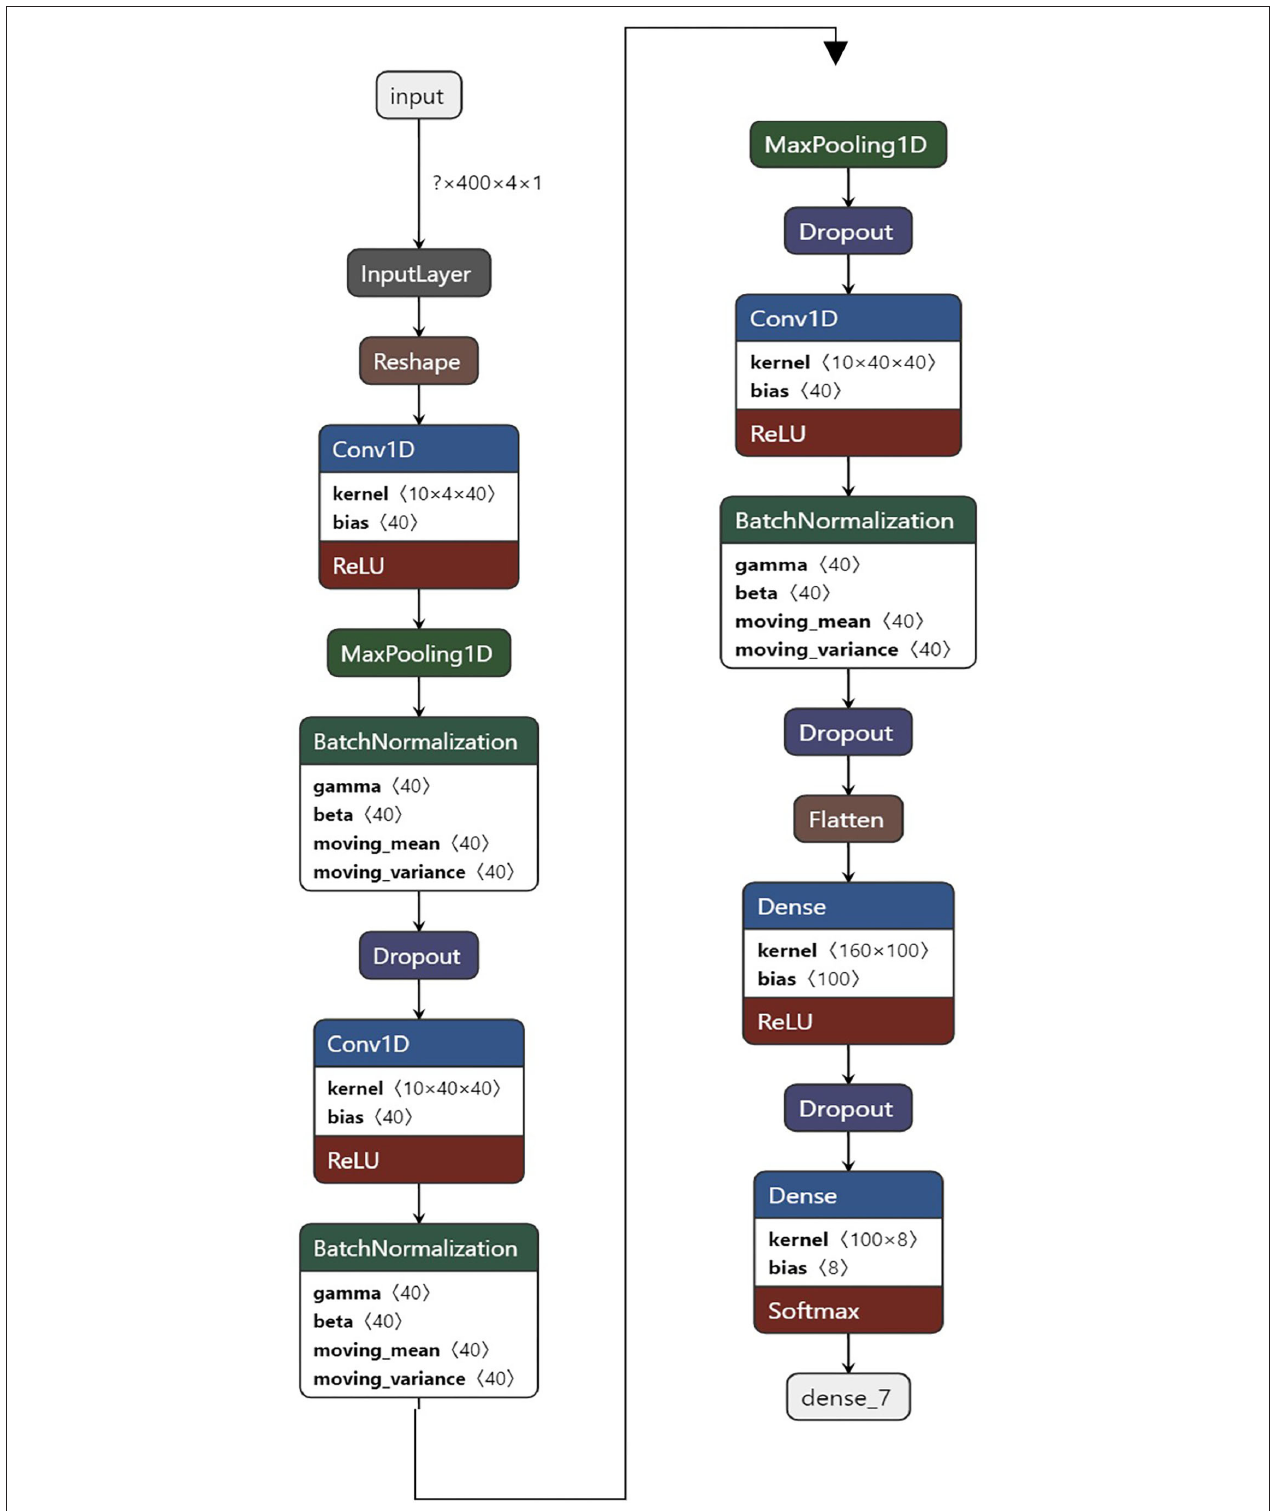
FIGURE 5 | Structure of the 1DConv neural network model used for the data of the eight dance movements. Input shape (time-steps, channels, 1) = (400,4,1) and output shape = 8 classes.